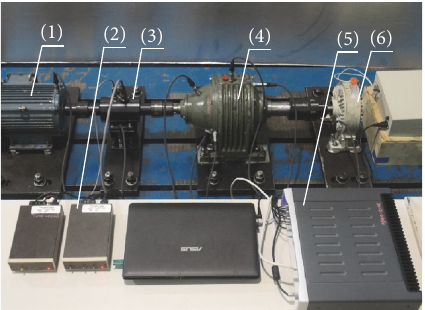
Figure 6: Planetary gearbox test rig: (1) drive motor, (2) signal conditioner, (3) torque-speed transducer, (4) planetary gearbox, (5) signal collector, and (6) magnetic powder brake.